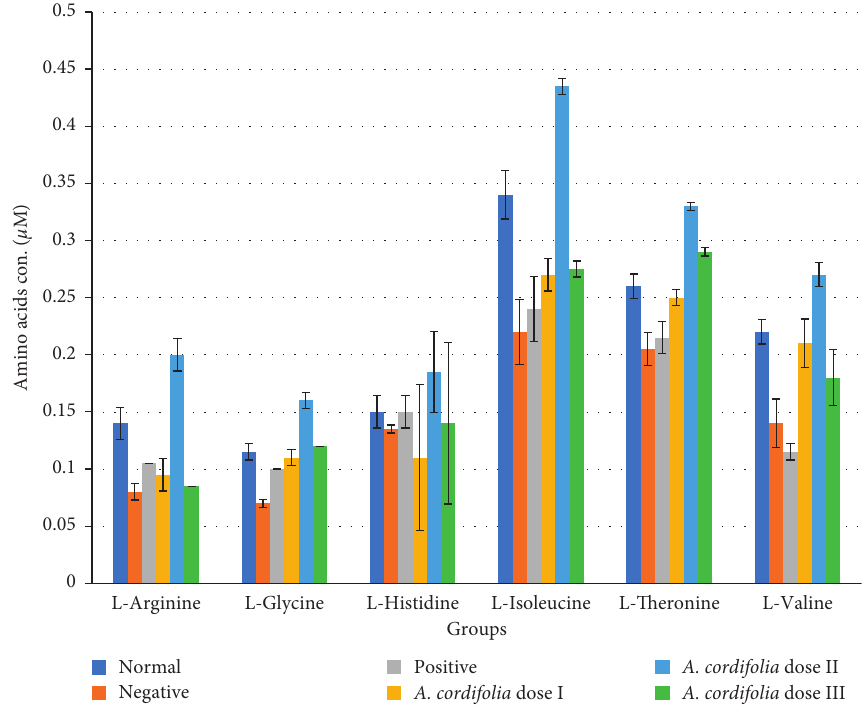
Figure 3: The level of plasma-amino acids lowers in diabetic rats as compared to normal rats. HFD lowered most of the amino acids, oral administration of A. cordifolia leaves extract doses 25, 50, and 100mg/kg body weight, and glibenclamide 0.51 mg/kg BW increased the plasma-amino acid as compared to untreated diabetic rats. All values are described as mean ± SD for five rats in each